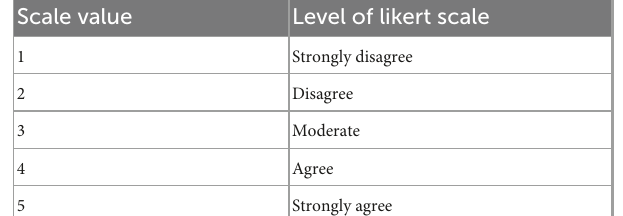
TABLE 1 Five point likert